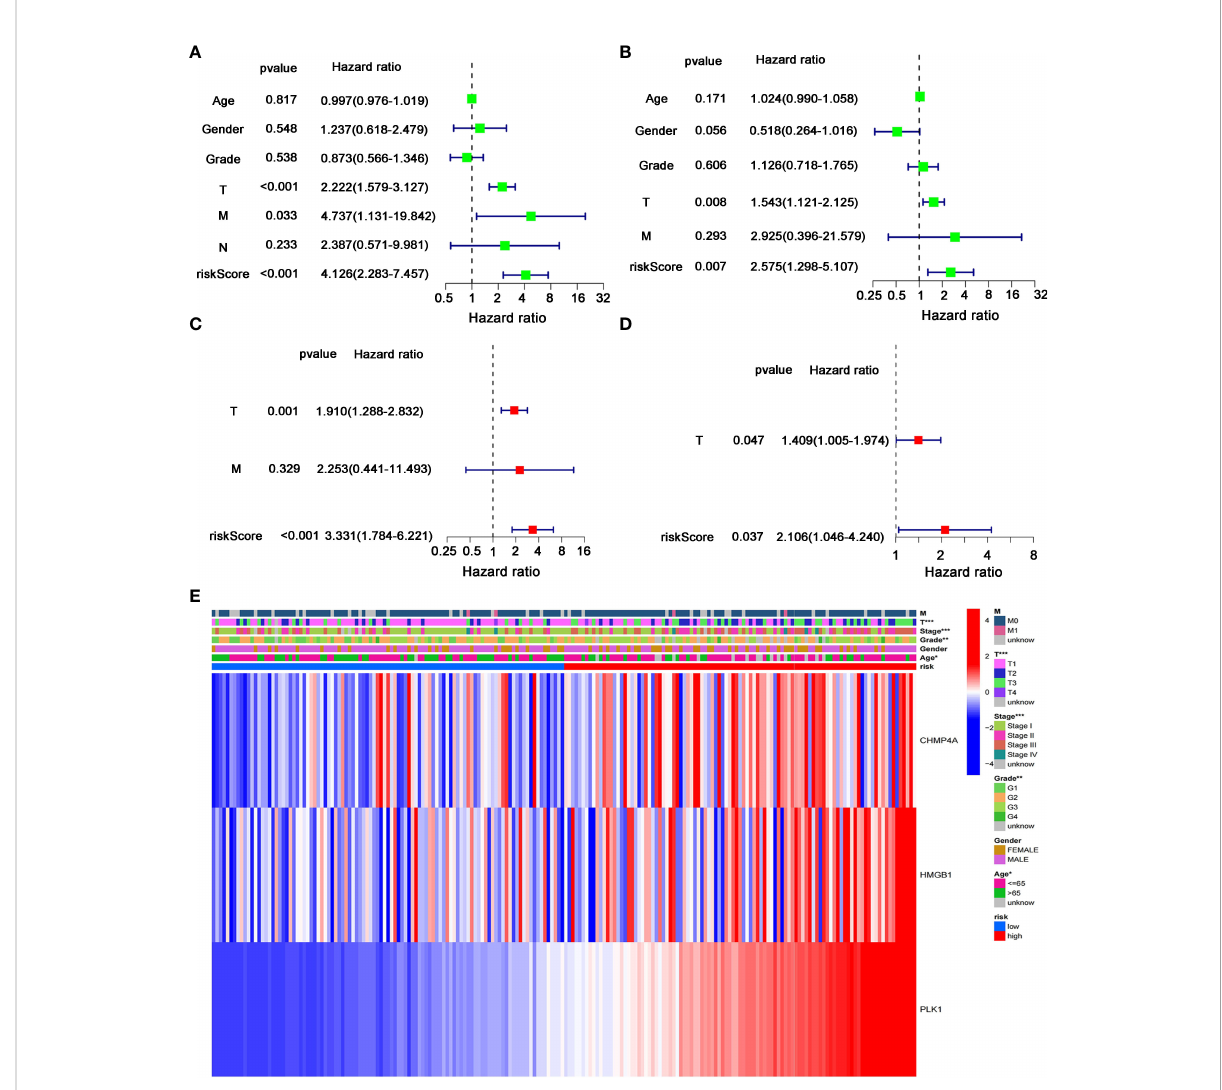
FIGURE 6 Independent predictive value of the prognostic model. (A, B) Univariate and (C, D) multivariate Cox regression analysis was separately used to assess the signi fi cance and hazard ratio value of risk score and clinical characters of HCC patients in the (A, C) training cohort and (B – D) test cohort. (E) Heatmap was presented to display the connections between clinicopathologic features and the risk groups. * P < 0.05; ** P < 0.01; *** P <